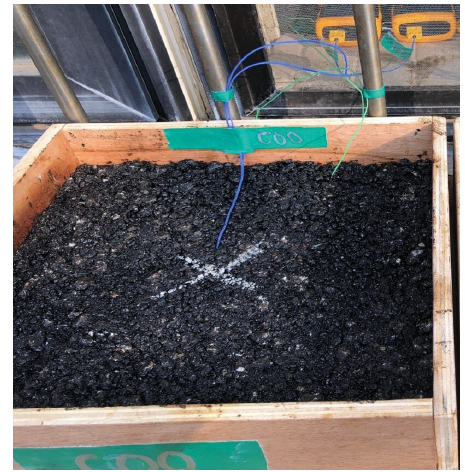
Figure 7. Measurement of surface